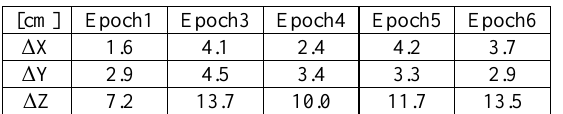
Table 4. The RMSE for RIBC for 18 evenly distributed images